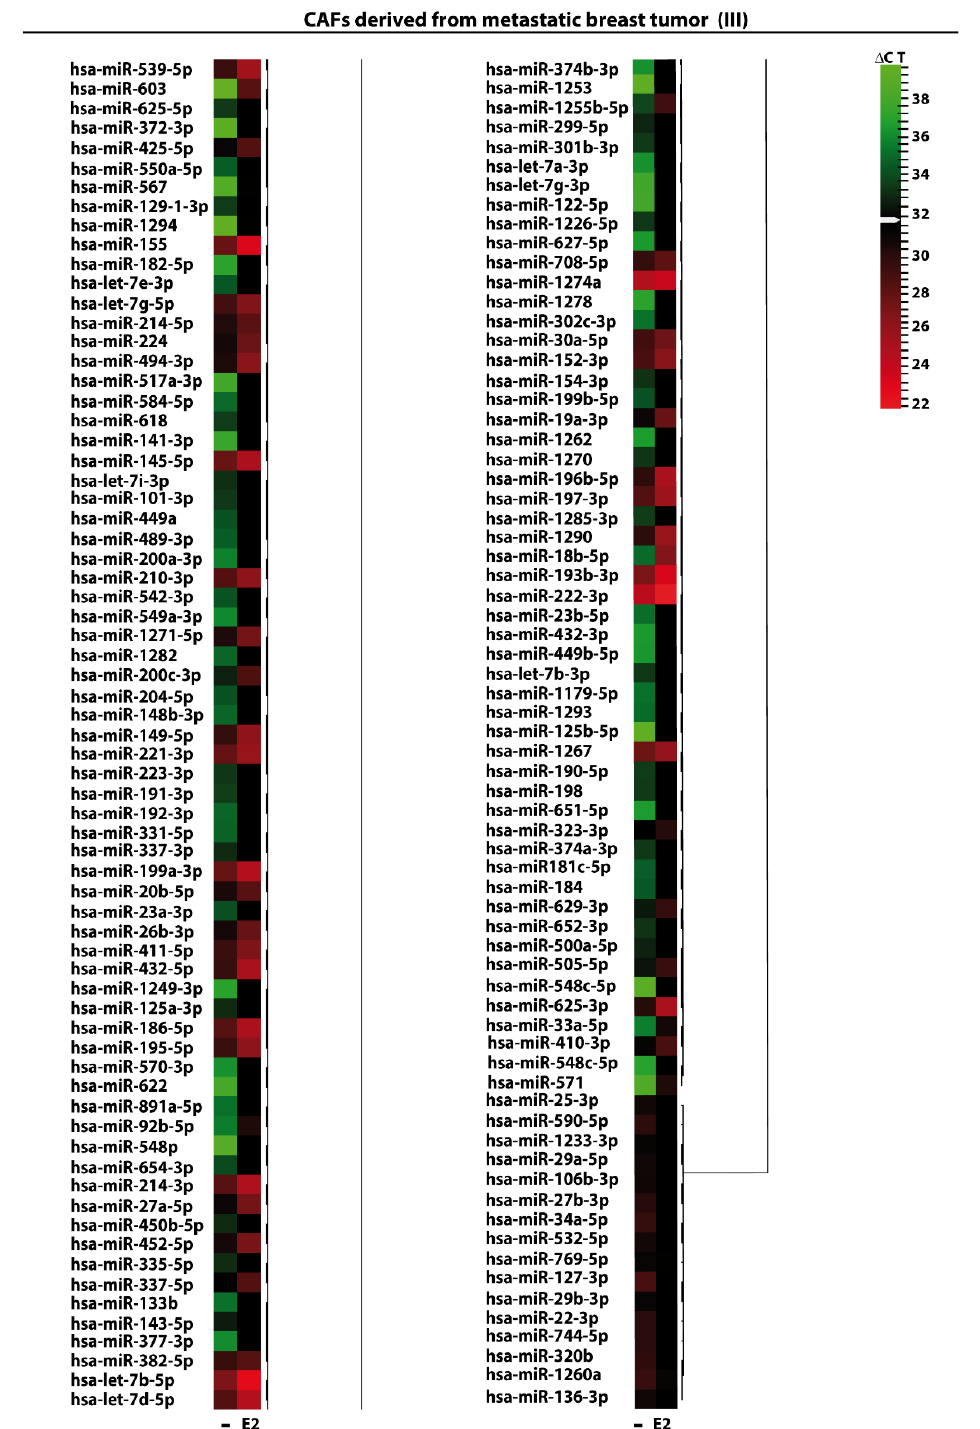
Figure 5. E2-modulated expression of miRNAs in CAFs derived from a cutaneous metastatic breast tumor. Heat Map representation of 139 E2-regulated miRNAs in CAFs derived from a cutaneous metastasis treated with 100 nM E2 for 4 h and analyzed by TaqMan Low-Density Array Human miRNA. Rows represent an miRNA and columns represent the treatment exposure. Each column is illustrated according to a colour scale from green (low expression) to red (high expression). The distance measured is Euclidean Distance and the clustering method is complete linkage. Dendrograms of clustering analysis for miRNAs and samples are displayed on the top and right,